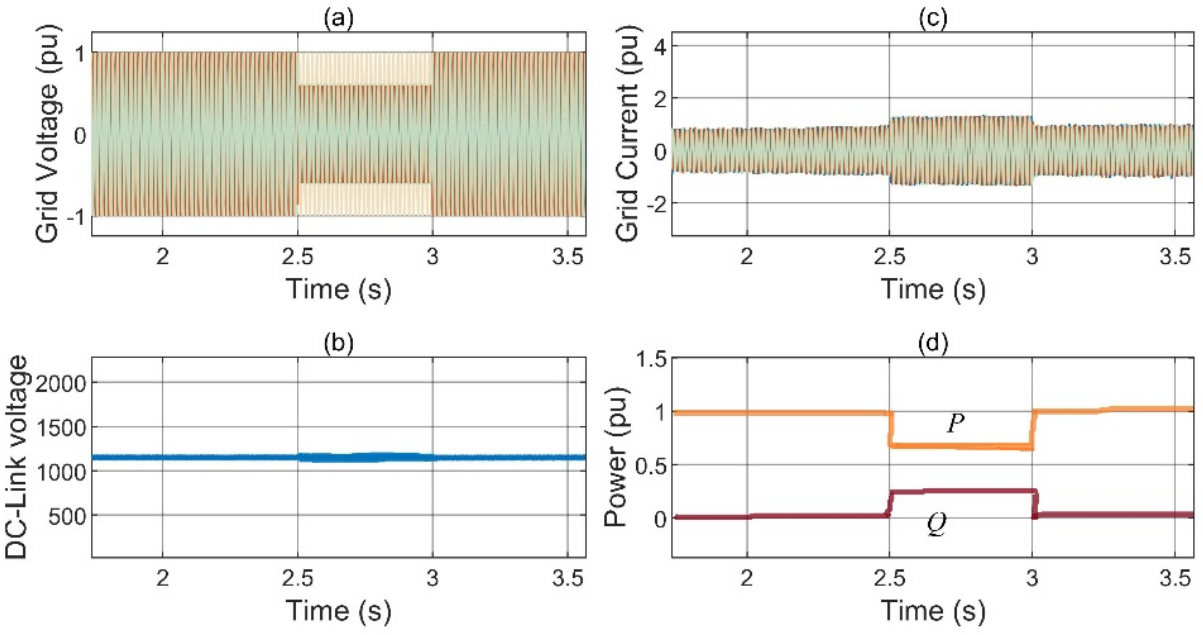
Figure 16. LVRT Performance of PI controller during asymmetrical grid fault. ( a ) Grid voltage ( b ) Inverter current ( c ) DC-link voltage ( d ) Active and Reactive power 4.3. Experimental Results In order to validate the performance of the proposed controller, an experimental setup is used as shown in Figure 17. The experimental verification is realized by OPAL- RT (OP5700) platform. The parameters of experimental tests are similar to those of simu- lation results. The sampling frequency of the FCS-MPC algorithm is 20 kHz, while the data sampling frequency is either 16 or 20 kHz, contingent upon the data logging duration as well as memory constraints.